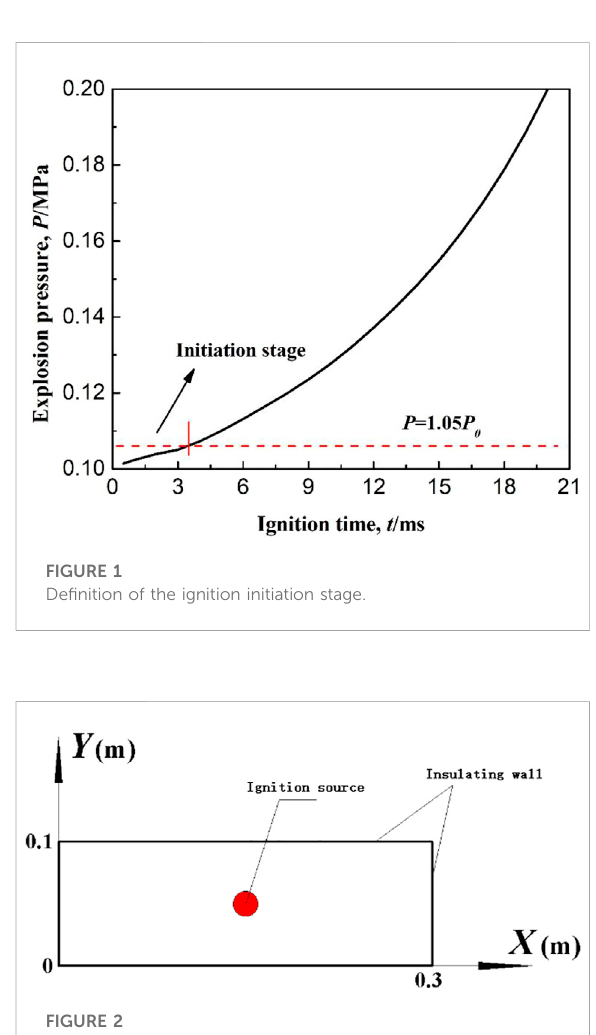
FIGURE 2 Computational